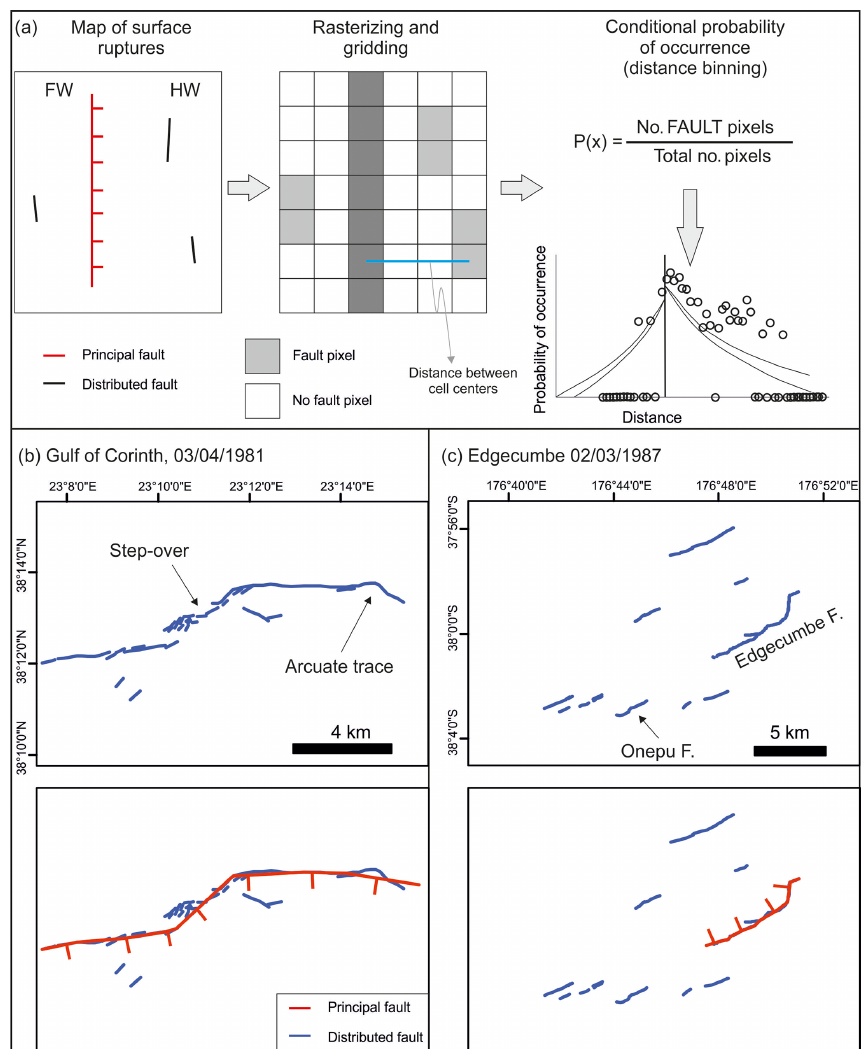
Figure 2. (a) Methodology for computing the conditional probability of faulting using the gridding approach. FW denotes footwall, and HW denotes hanging wall. (b) Example of a complex trace at the surface following the 1981 Gulf of Corinth (Greece) earthquake; ruptures are digitized from a map published by Jackson et al. (1982). (c) Example of a complex trace at the surface following the 1987 Edgecumbe (New Zealand) earthquakes; ruptures are from the SURE database (Baize et al.,